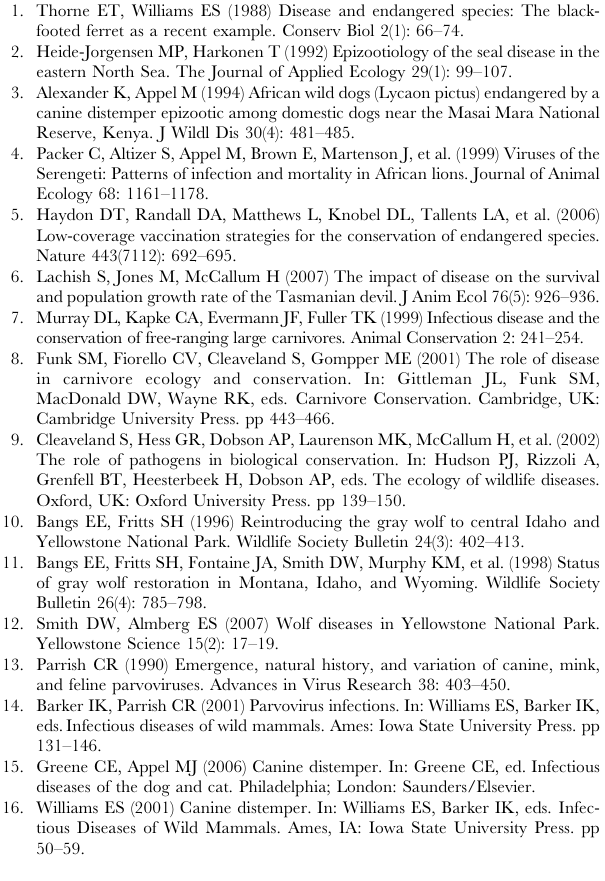
Table S3 Wolf and coyote canine distemper seroprevalence and associated 95% score confidence intervals. Sample sizes and the number of packs (for wolves) or regions (for coyotes) sampled are noted.